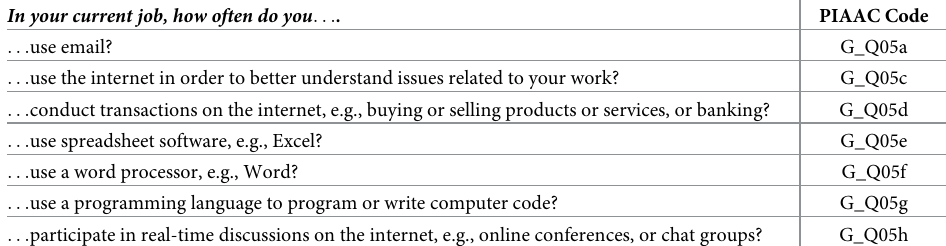
Table 6. ICT use at work variables in